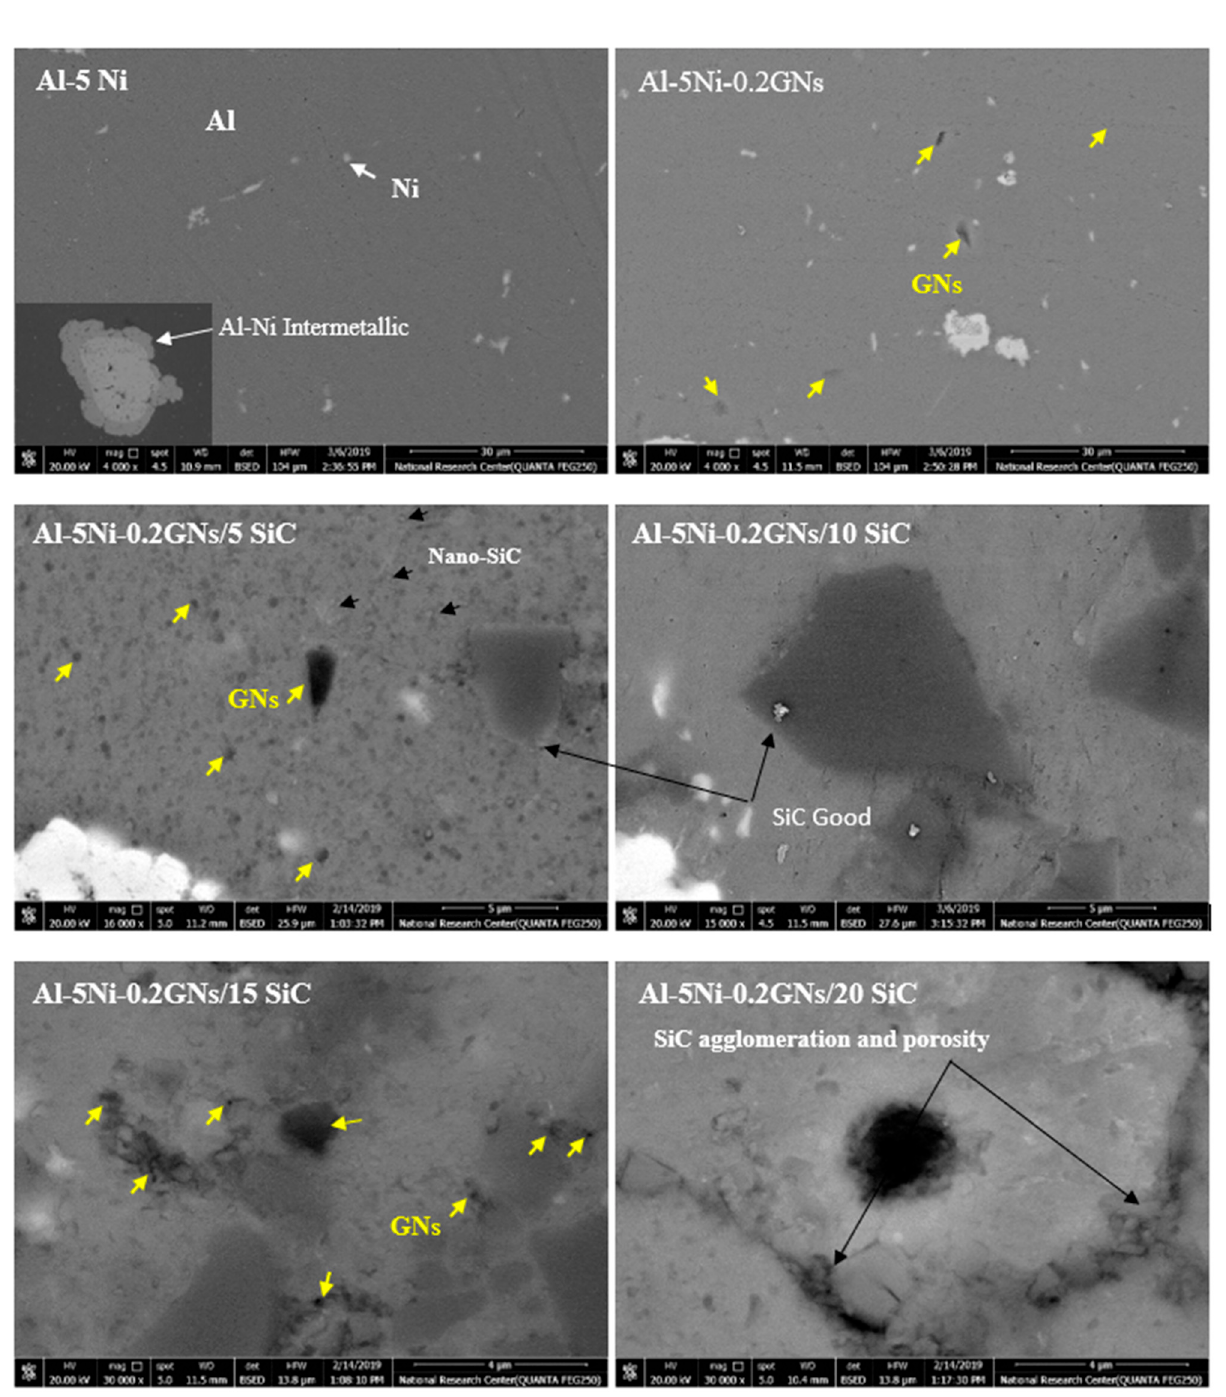
Figure 3. SEM (BSE) micrographs of fabricated